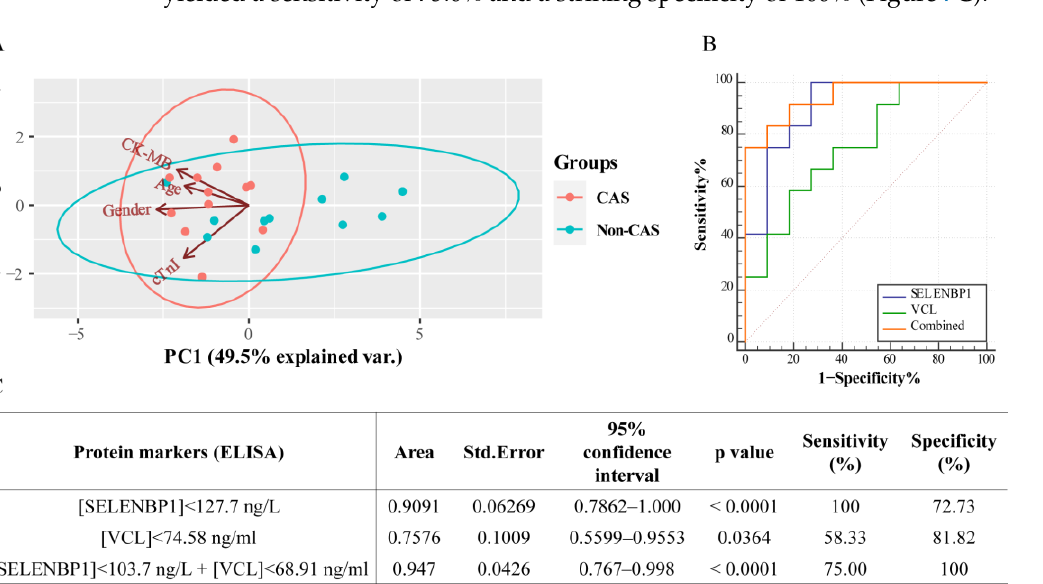
Figure 7. Combined SELENBP1 and VCL conferred improved diagnostic efficacy for forensic prac- tice. ( A ) PCA showed that the combination of decedents’ age, gender, CK -MB, and cTnI levels did not allow discrimination between CAS-induced sudden death and non-cardiac death. ( B , C ) A com- parison of the diagnostic efficacy in forensic cases for SELENBP1 and VCL alone and in combina-